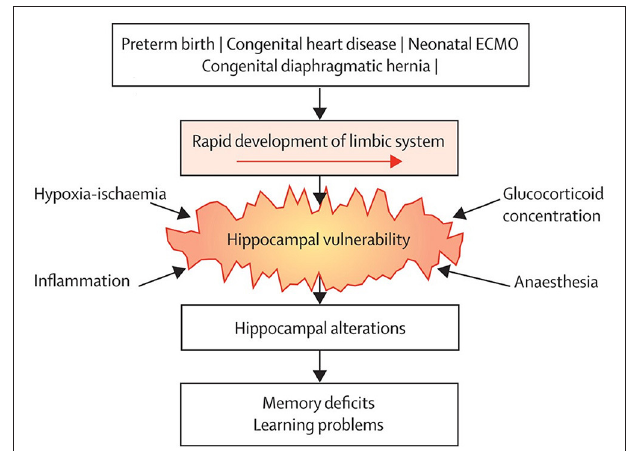
FIGURE 1 | Common neurodevelopmental pathway following neonatal critical illness. Survivors of neonatal critical illness share an increased risk of hippocampal alterations due to vulnerability to common conditions associated with neonatal critical illness, which leads to long-term memory deficits. ECMO = extracorporeal membrane oxygenation. Reprinted from The Lancet Child Adolesc Health Schiller et al. (83). Copyright 2018, with permission from